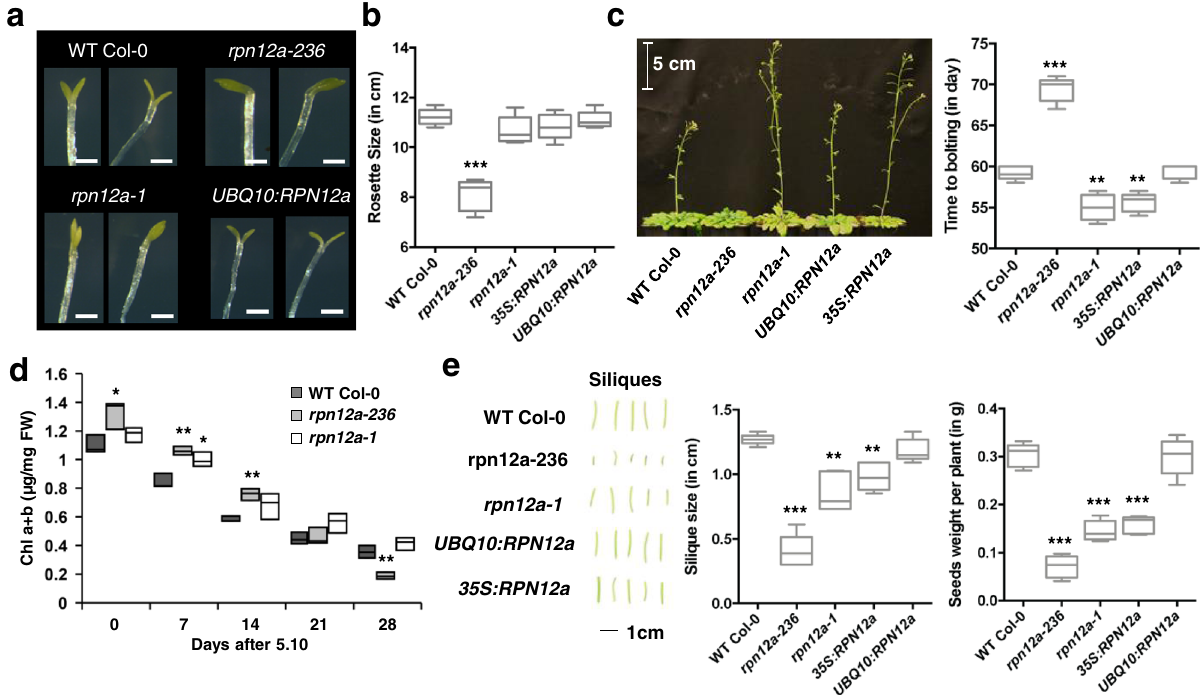
Fig. 2 Phenotypic characterization of rpn12a- 236 during growth and development and comparison with other lines. a Skotomorphogenesis of seedlings after 10 days in darkness. rpn12a-236 exhibits a reduced cotyledon opening and a marked apical hook. Scale bars = 0.1 cm. b Rosette diameter, and c Time to bolting measured at 5.10 developmental stage 18 for plants grown under short-day conditions ( n = 5 biologically independent replicates per genotype) d Chlorophyll content in leaves (rosette 7 to 12) undergoing developmental senescence ( n = 3 biologically independent replicates per genotype; box plots are min max and the middle line is the median). e Silique growth and seed production for all studied genotypes. ( n = 100 (i.e., 5 biologically independent replicates with 20 siliques each). For box and whiskers plots in b , c , and e , the interquartile range of the box is from the 25th to 75th percentiles, and the middle line is the median; whiskers represent min and max values; a Student ’ s t -test (two sided) showed statistically signi fi cant differences at * p < 0.05, ** p < 0.001, *** p < 0.0001 when compared to WT.